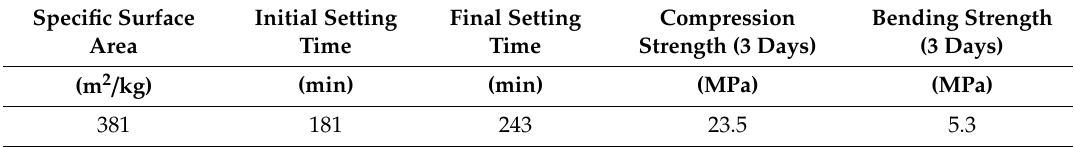
Table 1. Physical and mechanical properties of P.O42.5 ordinary Portland cement.